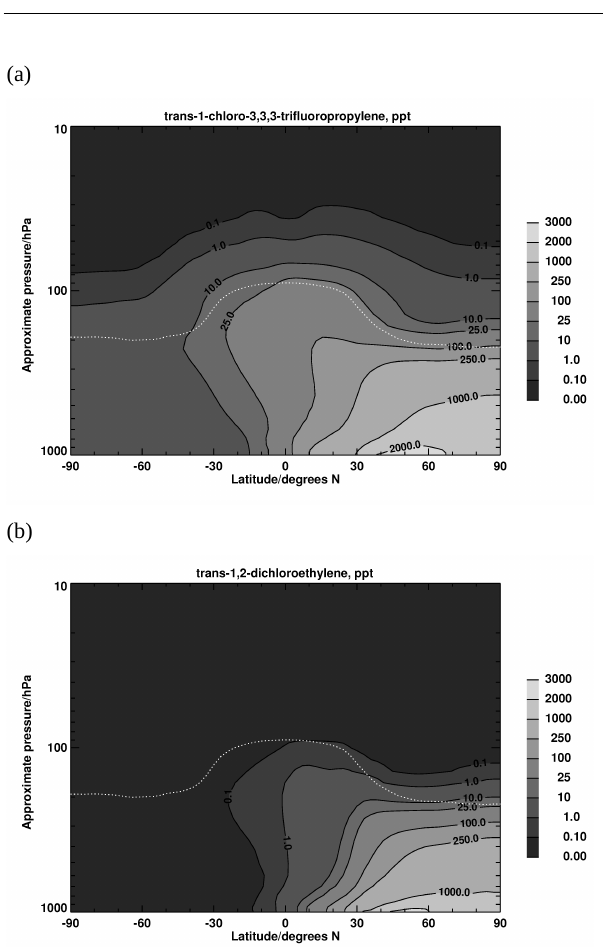
Figure 1. Annually and zonally-averaged mixing ratio in ppt of the chloroalkenes obtained in MOZART 3 for emissions from the land masses between 30 °N and 60 °N. In this and the following figures, the white dotted line shows the average tropopause pressure. (a) trans-1-chloro-3,3,3-trifluoropropylene (tCFP) at 1.64 × 10 10 molec cm -2 s -1 . (b) trans-1,2- dichloroethylene (tDCE) at 2.21 × 10 10 molec cm -2 s -1 .